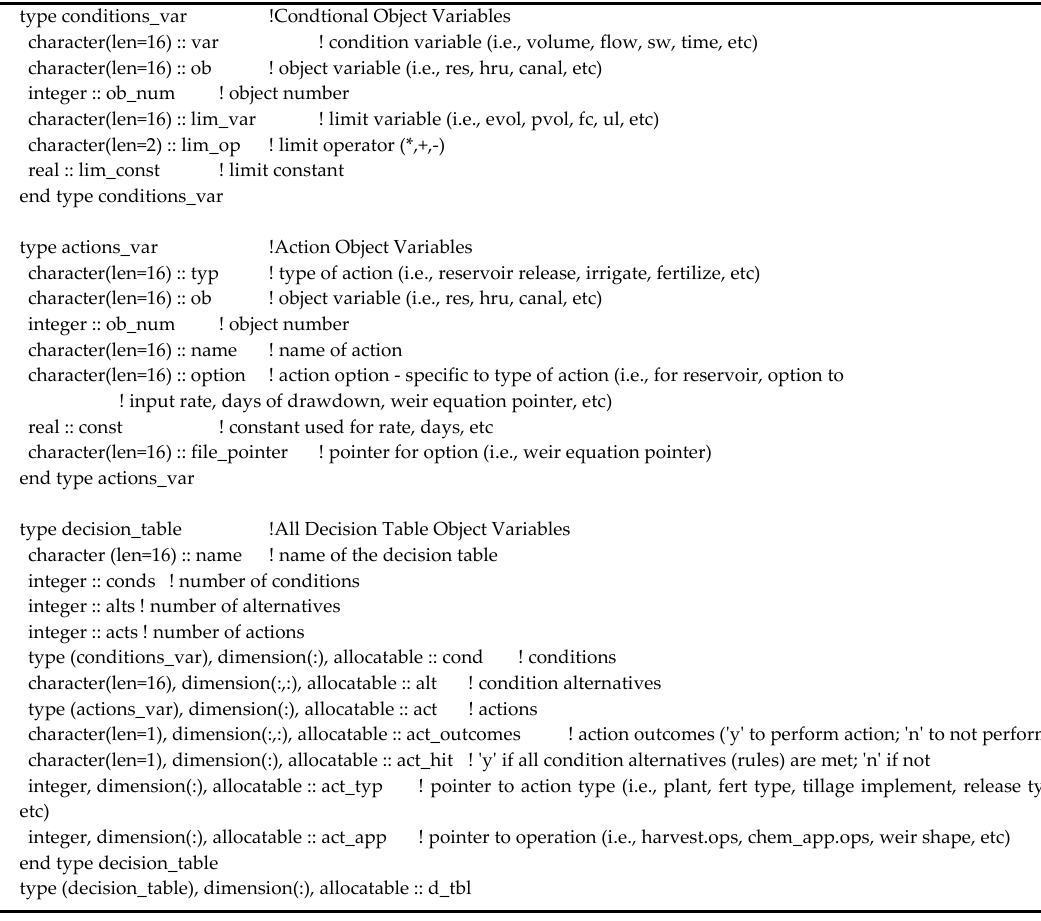
Table 4. Decision table variables as coded in the SWAT+ model.